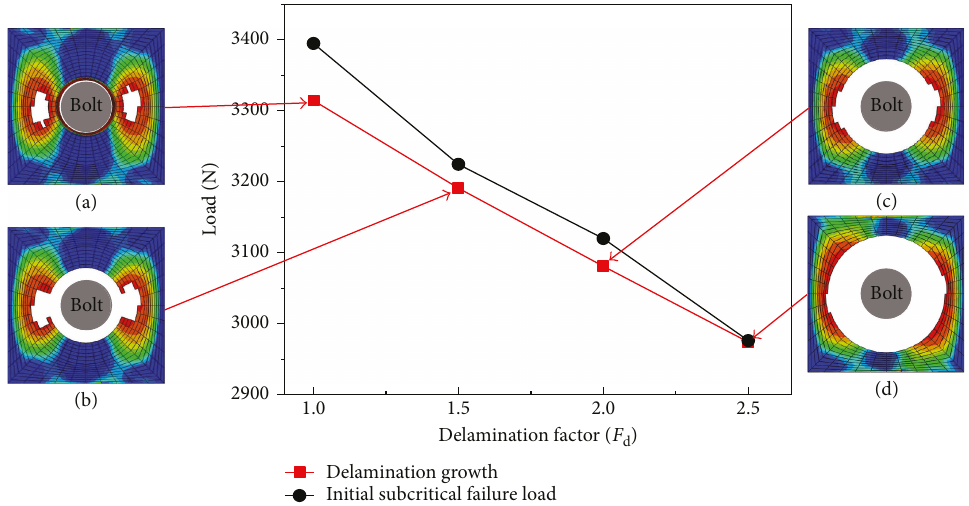
Figure 11: E ff ect of F on the delamination initiation, initial subcritical failure load, and the propagation of delaminated area: (a) F d F =1.5, (c) F =2.0, and (d) F =2.5. d d d